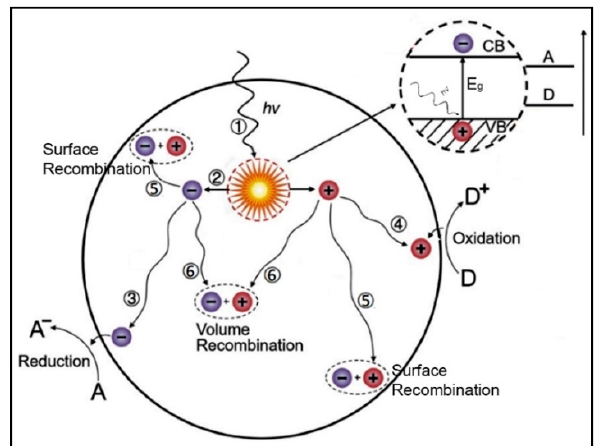
Figure 3. Pathways of the photogenerated charge carriers in a semiconductor photocatalyst. Adapted with permission from reference [149]. Copyright 2013 John Wiley and Sons.